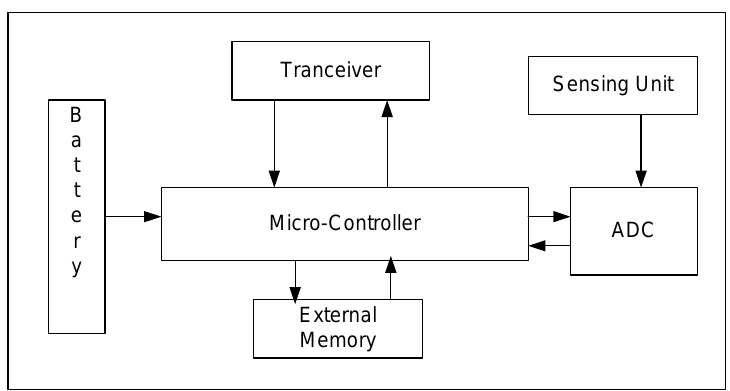
Figure 1. Sensor Node